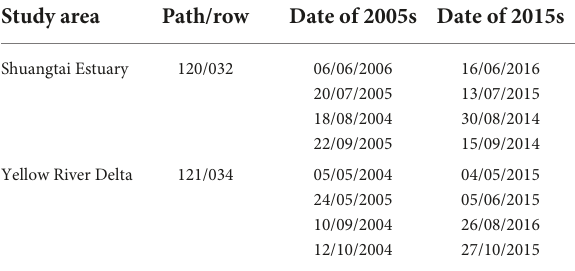
TABLE 1 Acquisition dates of Landsat